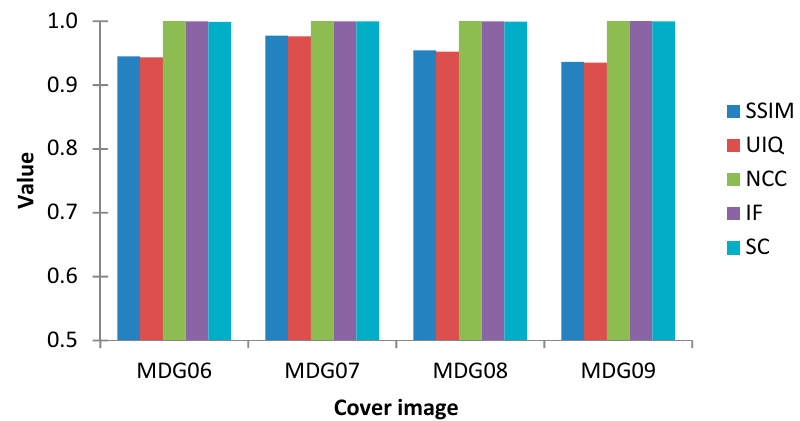
Figure 13. Graphical representation of performance analysis of the proposed steganography scheme where the secret medical image (MDG10) is embedded onto the remaining cover greyscale images presented earlier in Figure 3 (i.e., those labelled MDG06 through MDG09). Table 4. Comparison between proposed protocol and similar quantum-based data hiding techniques in terms of embedding capacity and mean values of PSNR, SSIM, and UIQ. Mechanism PSNR SSIM UIQ